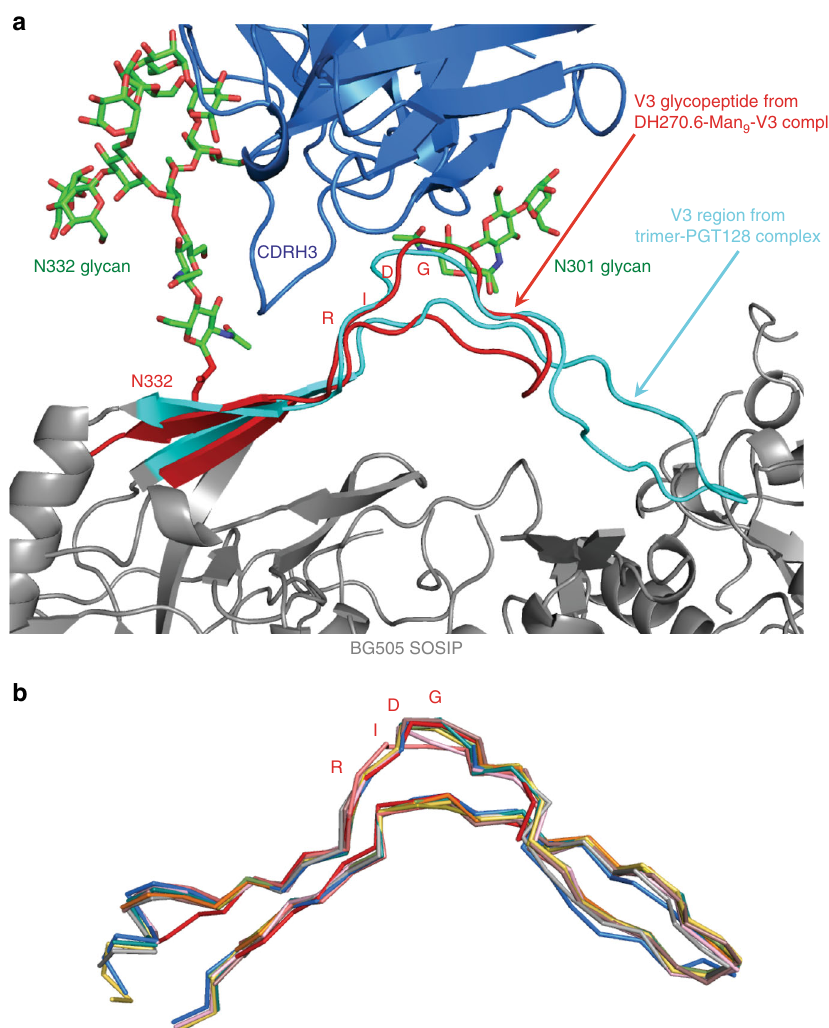
Fig. 3 HIV trimer V3 region compared to V3 glycopeptide. a Superposition of the V3 glycopeptide (red) from the DH270.6-Man 9 -V3 complex onto the V3 region (cyan) of the PGT128-BG505 complex (PDB ID: 5ACO). Glycans from the DH270.6-Man 9 -V3 complex are shown as green sticks. b Superposition of V3 glycopeptide (red) from the DH270.6-Man 9 -V3 complex onto the V3 region of other HIV Envs (both in complex, and unliganded) (PDB ID ’ s 4ZMJ 47 , 5CEZ 10 , 5I8H 48 , 5FYK 49 , 5FYJ 49 , 5T3S 50 , 5V8L 51 , 5T3Z 52 )